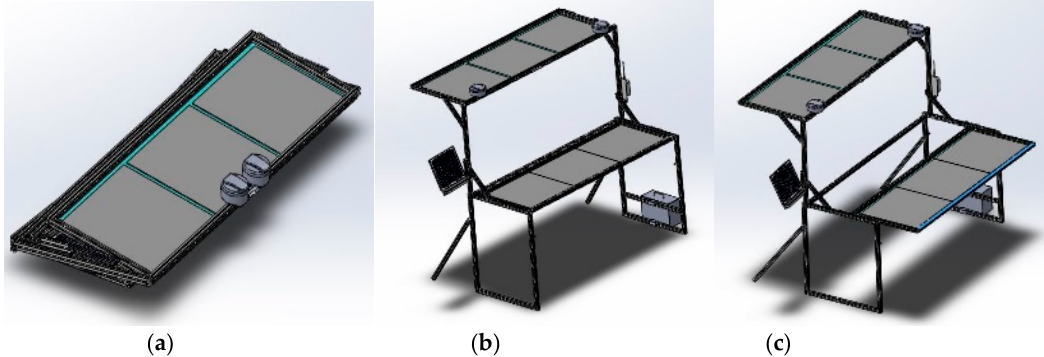
Figure 3. Structure of the aluminum frame of the multi-functional GCP which is ( a ) portable, ( b ) two level layers and ( c ) extendible for the bottom panel.